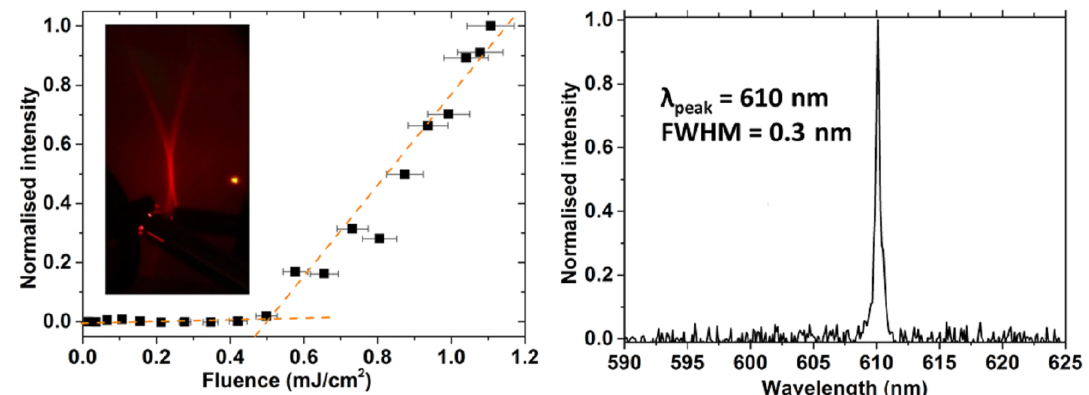
Figure 11. ( left ) Excitation density dependence of the emitted intensity of the CdSe/ZnS-PMMA distributed feedback (DFB) laser, evidencing the presence of a clear lasing threshold. Inset: far field distribution of the DFB emission above threshold. ( right ) Emission spectrum above threshold, evidencing monochromatic and narrow laser emission. Reprinted with permission from [84]. OSA publishing,